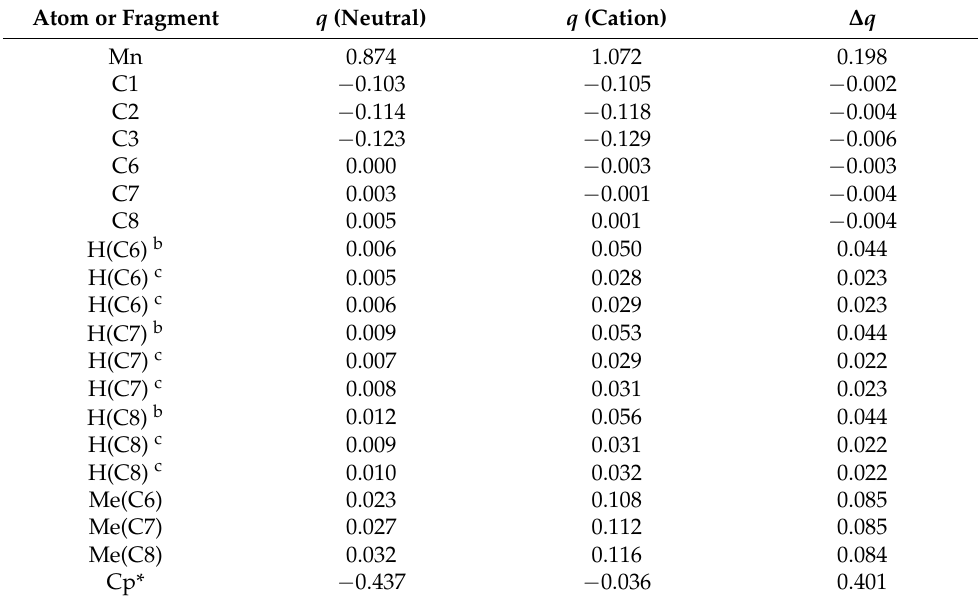
Table 3. Charges q (a.u.) on selected atoms a and fragments in the optimized Cp* 2 Mn 0 neutral and Cp* 2 Mn + cation and their change upon ionization ∆ q